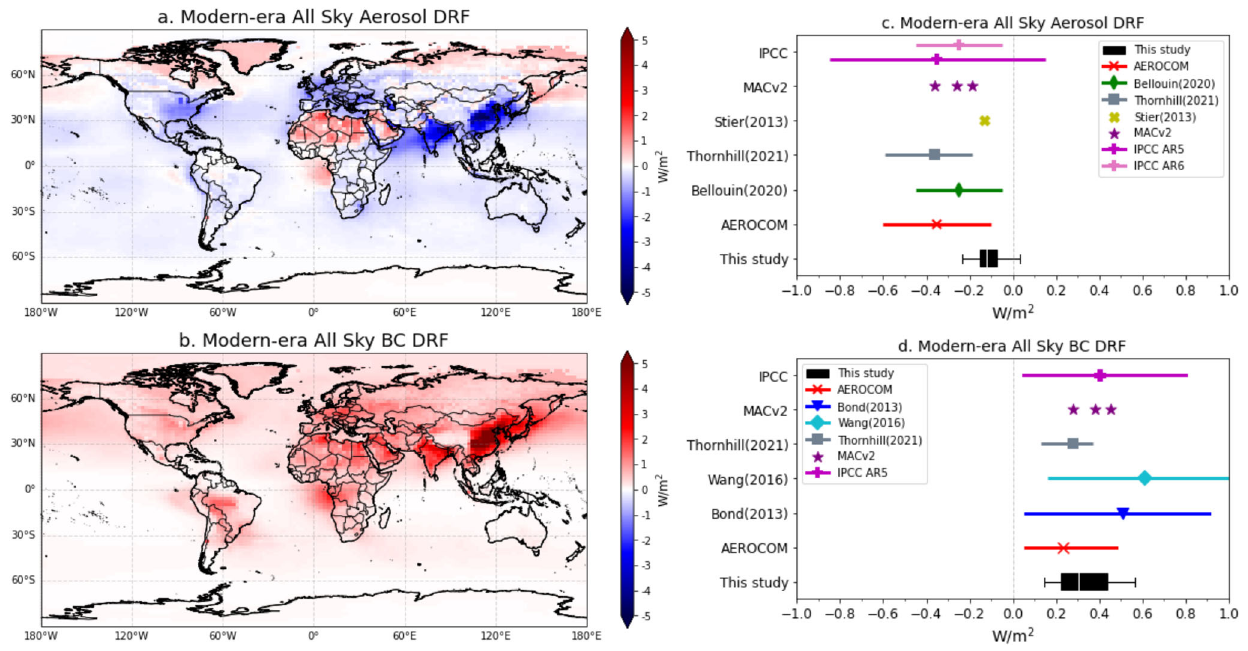
Fig.2|Modern-eraaerosoldirectradiativeforcing(DRF)andblackcarbon(BC) DRF constrained by satellite observations. a Spatial distribution of modern-era all-sky aerosol DRF averaged from 2006 to 2011. b Spatial distribution of modern- era all-sky BC DRF averaged from 2006 to 2011. c Modern-era aerosol DRF inter- comparison with the Assessment Reports of the Intergovernmental Panel on Cli- mate Change (IPCC AR5 and AR6), Bellouin 2 , Stier 83 , the Max Planck Institute